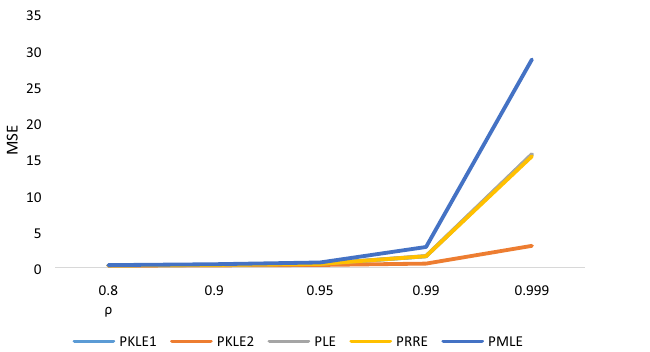
Figure 5. Intercept = 1; n = 200; p = 7.